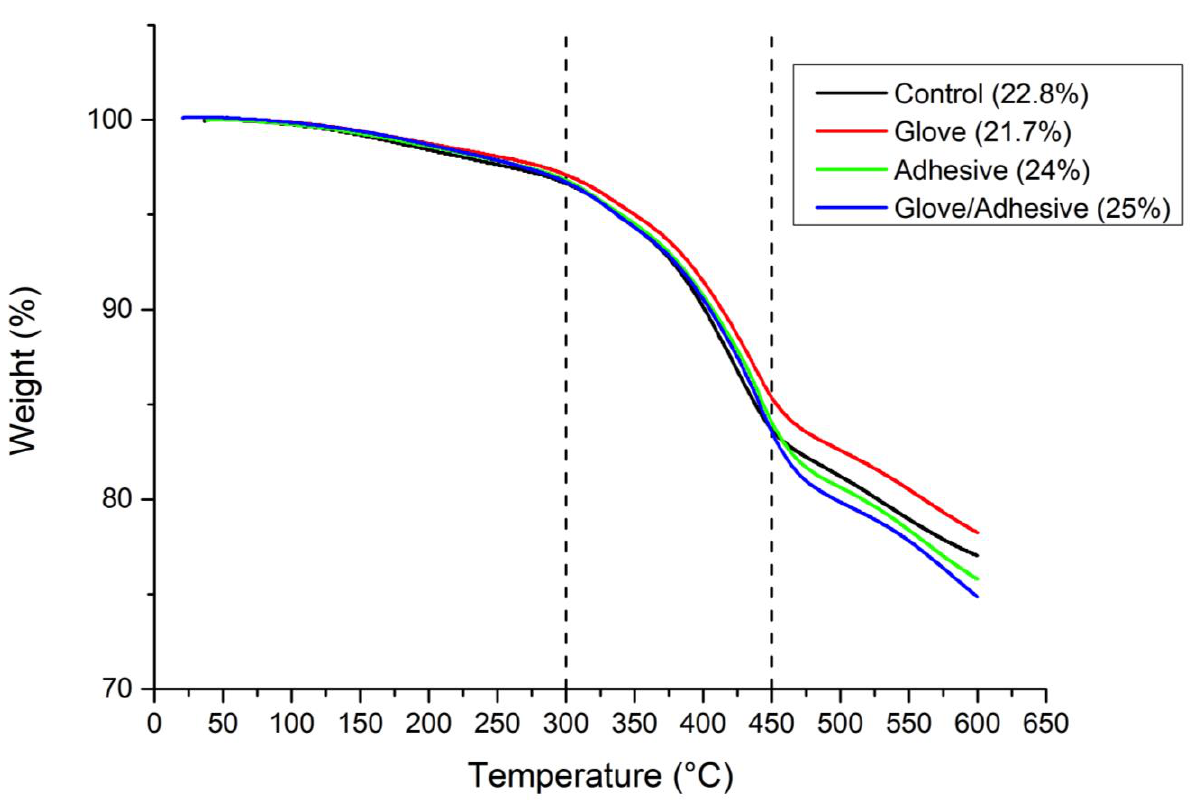
Figure 1. Thermogravimetric analysis (TGA) of composite resin specimens handled/modeled under different techniques (gloved-hands and/or adhesive): weight loss x